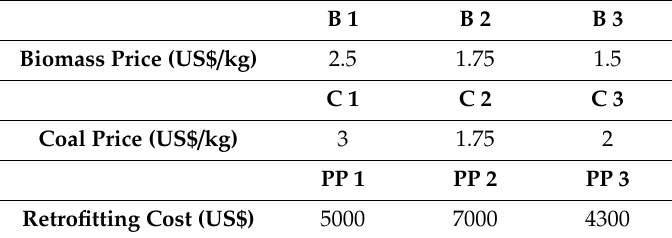
Table A4. Biomass and Coal Purchase Costs and Retrofitting Costs.